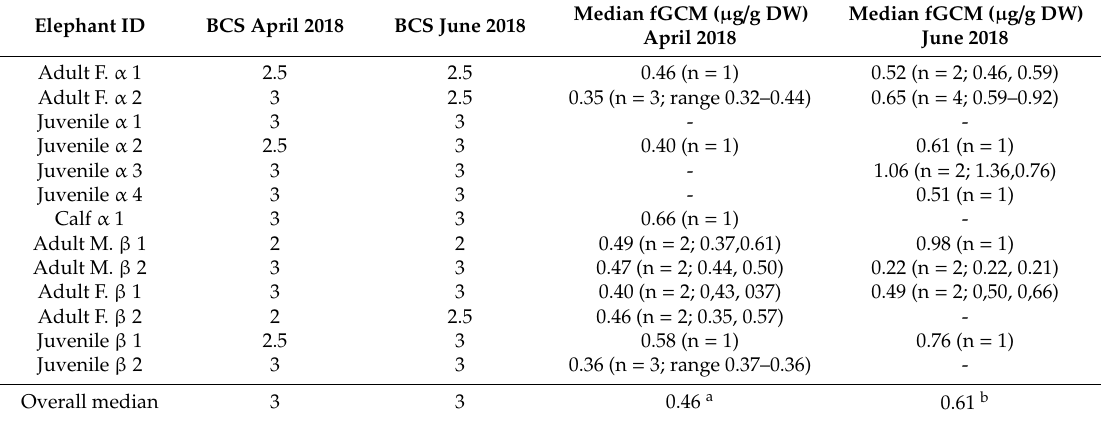
Table 1. Individual body condition scoring (BCS) and fecal glucocorticoid metabolite (fGCM) concentrations of 13 elephants assessed in April and June 2018. BCS was done on a point scale ranging from 1 to 5. Individual median fGCM concentrations were calculated if the individual sample size was n > 1 for a respective month (number of individual samples collected and the values or range are given in brackets